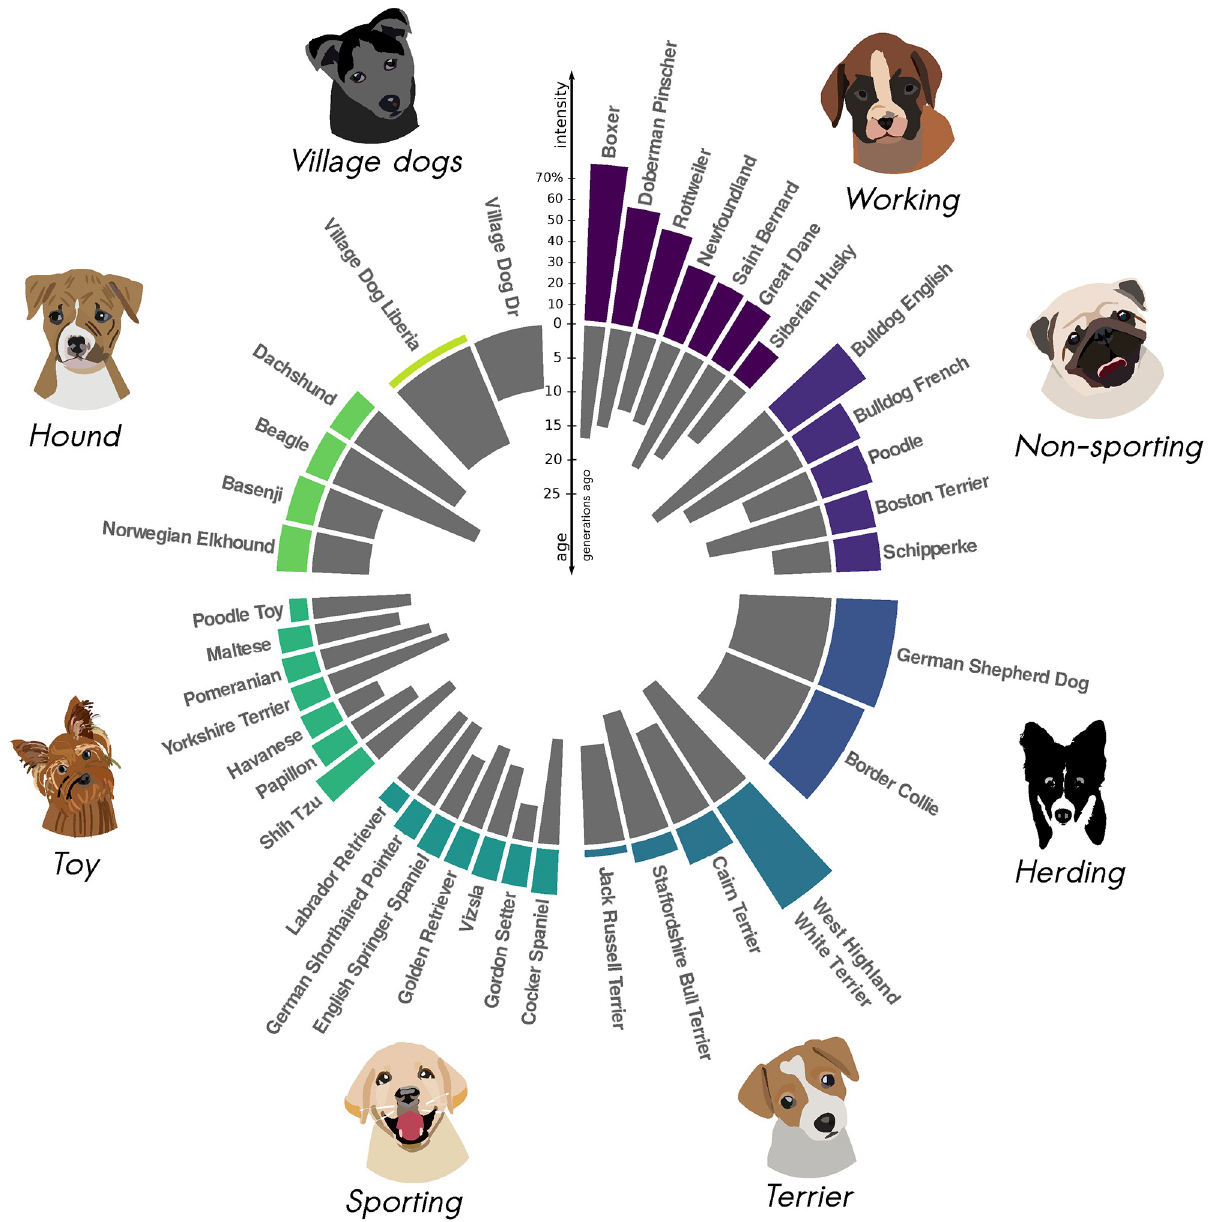
Fig 4. History of extreme founder events in dogs. Results of ASCEND for all dog breeds that passed the filtering criteria and showed evidence for significant founder events in the Hayward dataset (see Methods). The breeds are grouped according to their role as reported by the American Kennel Club database. The outer (colored) rim represents the founder intensity, with bar height proportional to the founder intensity. Note that within each role category, breeds are classified by decreasing founder intensity in the clockwise direction. The inner (gray) rim represents the founder age (in generations before present), with the bar height proportional to the founder age. The width of the bars is inversely proportional to the number of breeds within each role category. Icons were retrieved from openclipart.org.